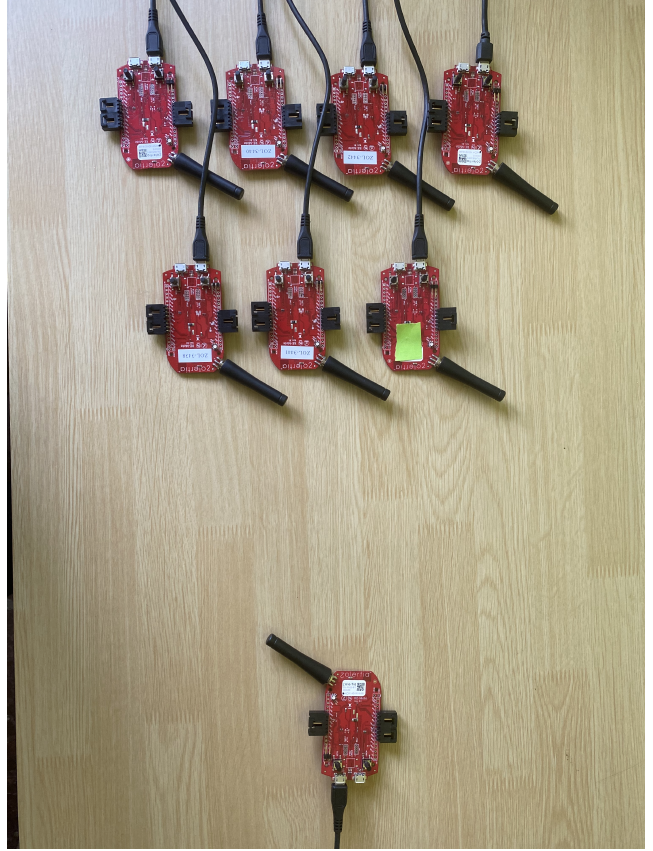
Figure 6. Testbed deployment using Zolertia RE-Mote